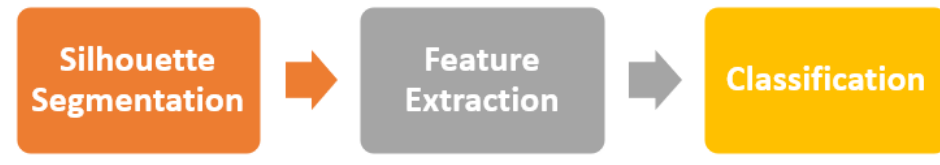
Figure 2. The process flow of the gait recognition system.